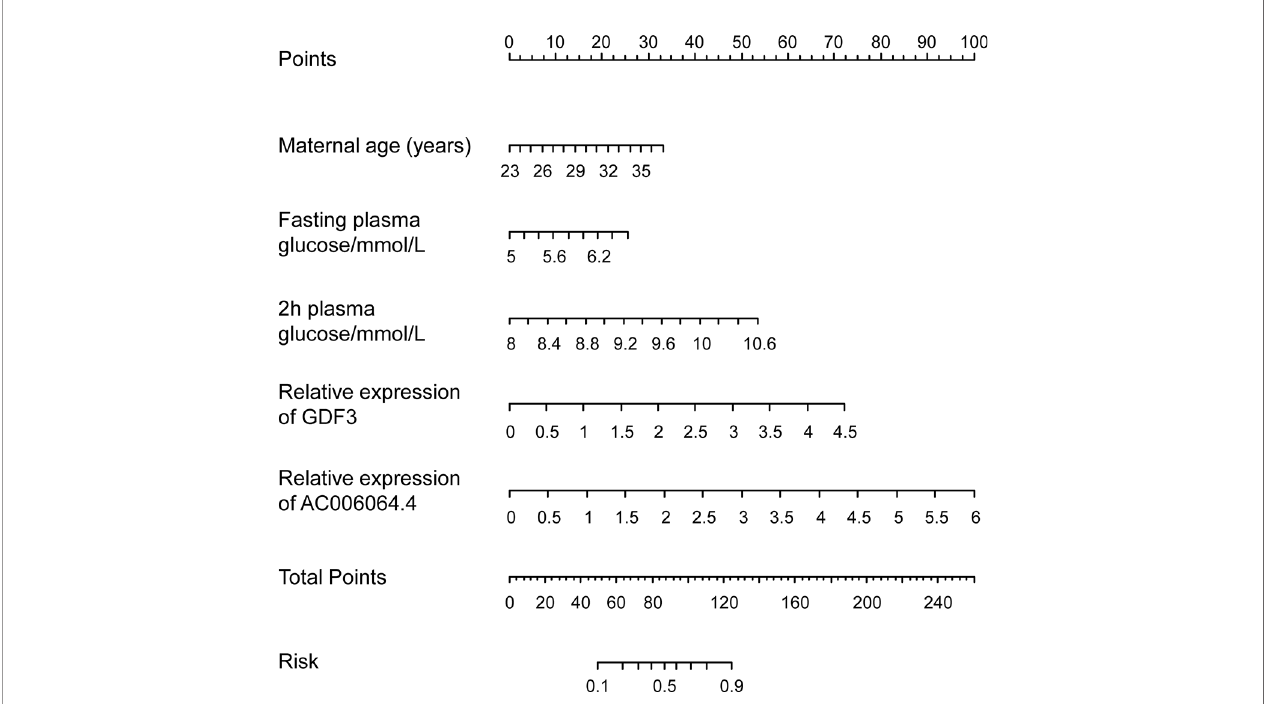
FIGURE 4 | Predictive graphical nomogram for macrosomia risk from patients with GDM. Predictors included maternal age, fasting plasma glucose, 2-h plasma glucose, GDF3 expression, and AC006064.4 expression in peripheral blood exosomes. GDM, gestational diabetes